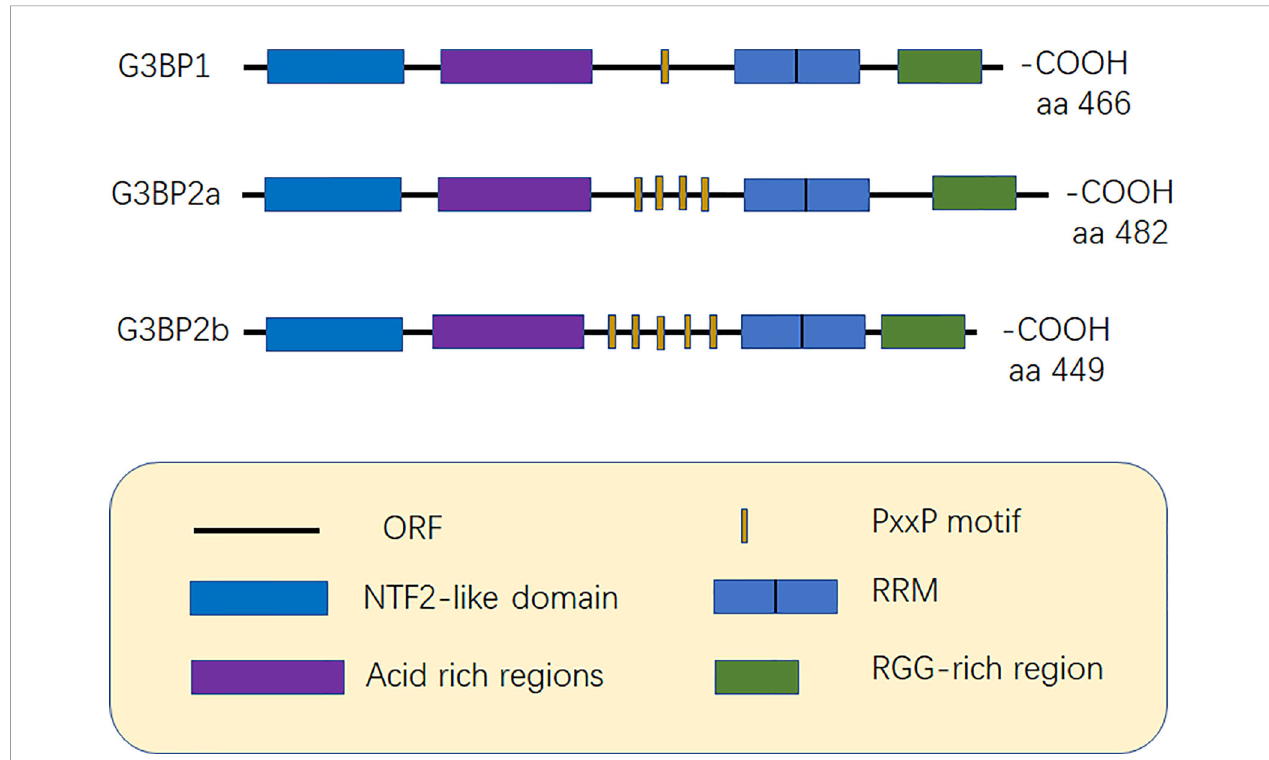
FIGURE 1 | Structure of G3BP. G3BP1 contains fi ve distinct motifs, nuclear transport factor 2 (NTF2) domain, Acidic-rich region, proline-rich (PxxP) motif, RNA recognition motif (RRM), and RGG domain (arginine -glycine-rich boxes), at the C-terminal. G3BP1 and G3BP2 can be distinguished according to the number of PxxP motifs as G3BP1 has one PxxP motif, while G3BP2a and G3BP2b have four and fi ve PxxP motifs, respectively (6,